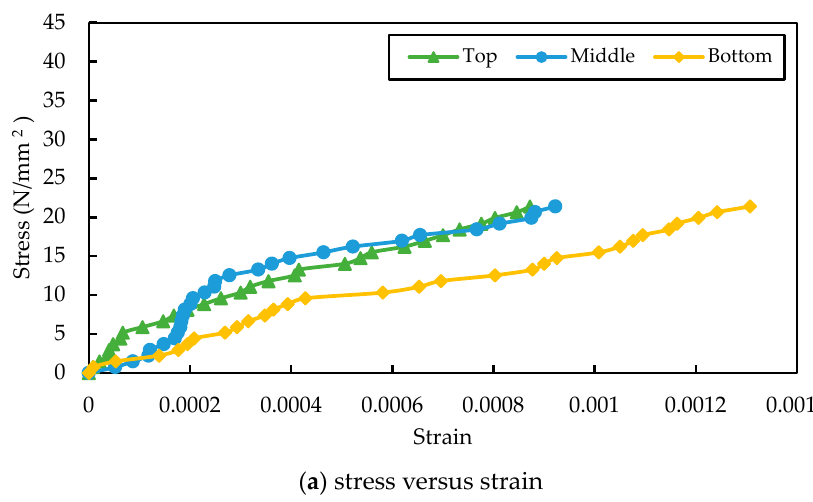
( a ) stress versus strain